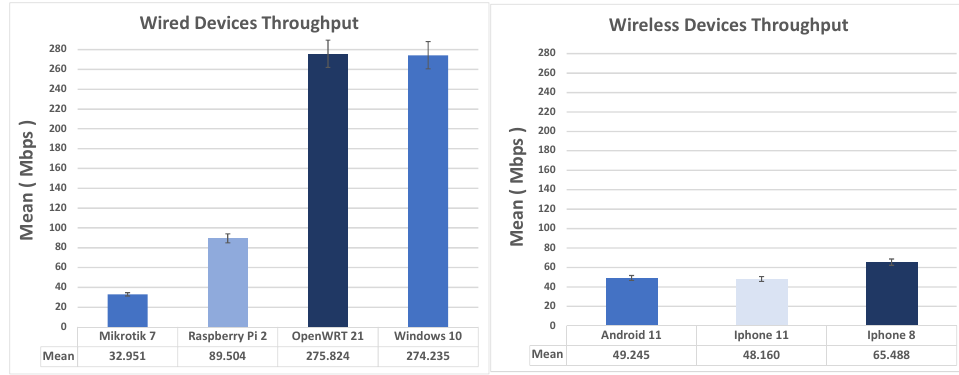
Figure 13. Comparison of the average Throughput in Wireguard Road Warriors